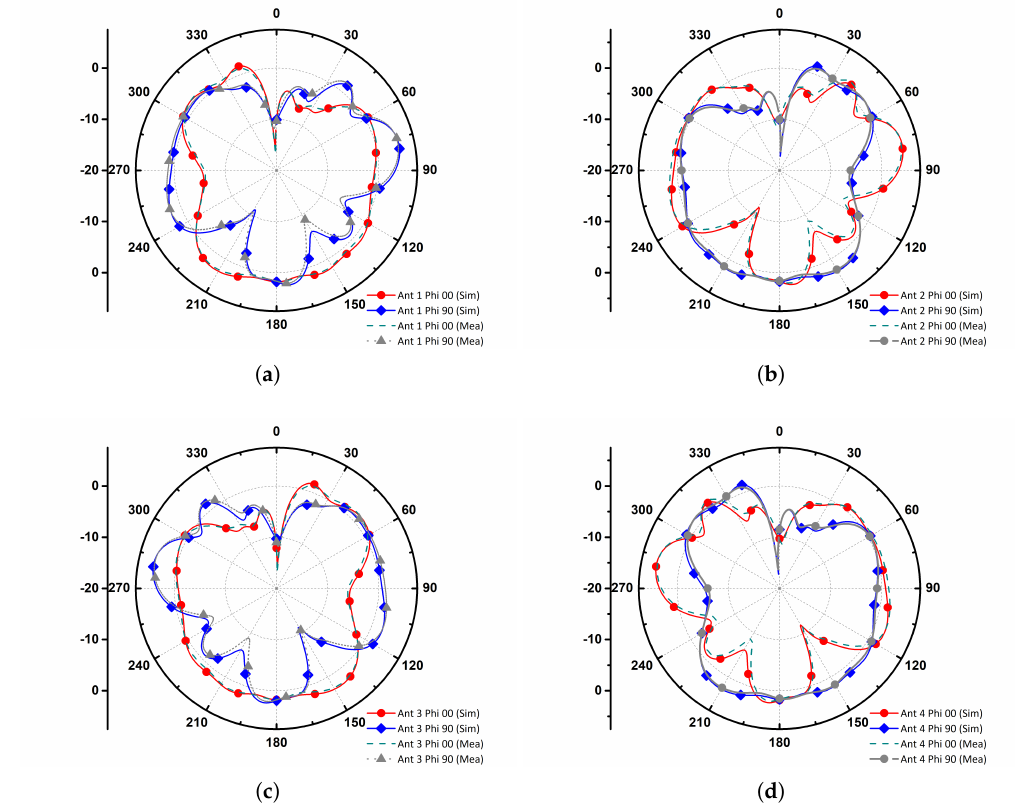
Figure 6. Simulated and measured radiation patterns: ( a ) AE-1 ( b ) AE-2 ( c ) AE-3 ( d ) AE-4. The polar coordinates show degrees, the y-axis is plotted in dBi.